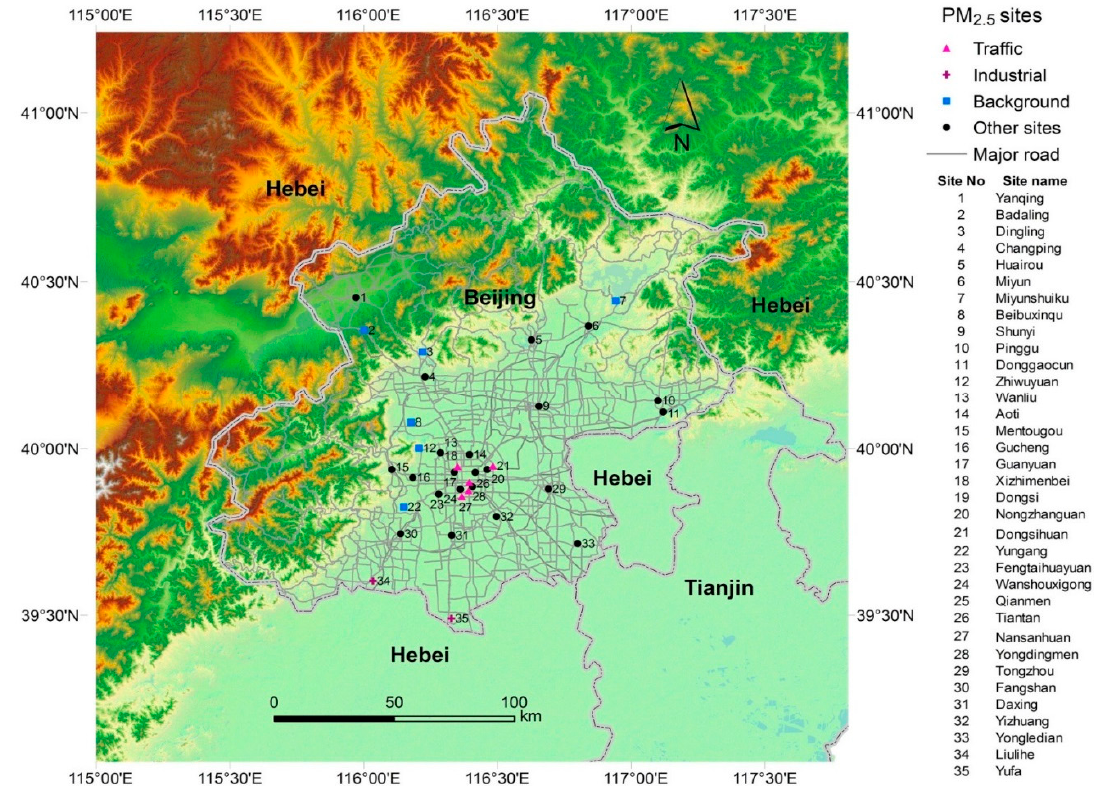
Figure 1. Distribution of 35 Air Quality Mornitoring (AQM) stations in Beijing.